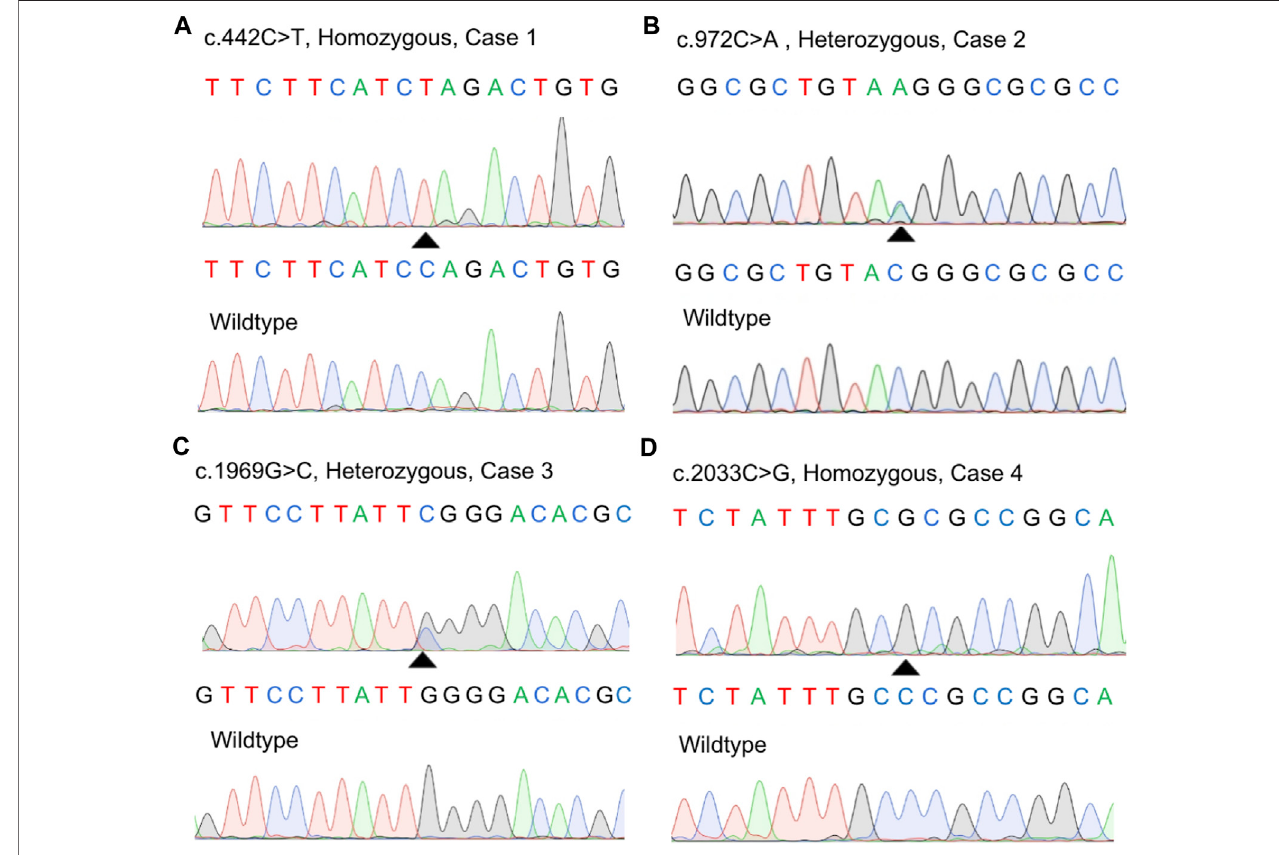
FIGURE 1 | Identi fi cation of four novel variants in our study. (A – D) Sanger sequences of the MYORG variants in the four cases and corresponding wild-type subjects.